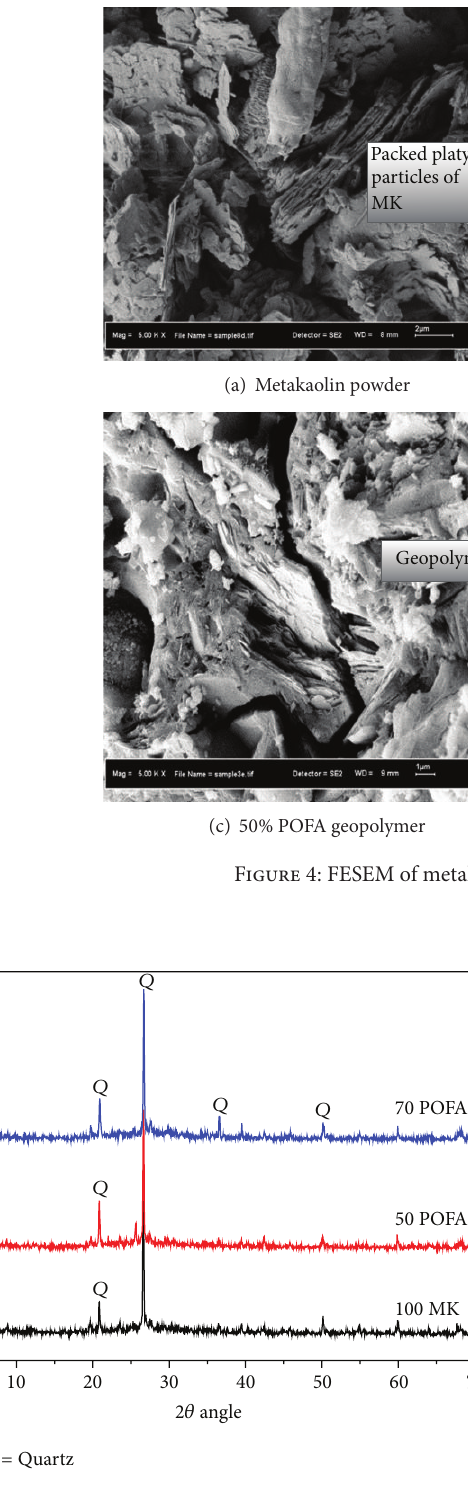
of metakaolin starting material are shown in Figure 3 and those of geopolymer specimen are shown in Figures 4(a), 4(b), 4(c), and 4(d). The gel formation in the